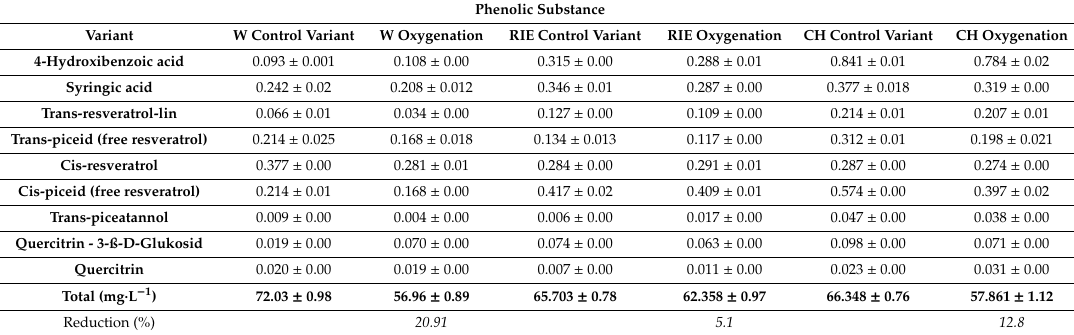
Table 7. Content of nine other monitored phenolic substances in mg · L − 1 from individual variants in 2016. The total amount of all 19 monitored substances and their percentage reductions from the variants processed by oxygenation in comparison with the control variant with the standard